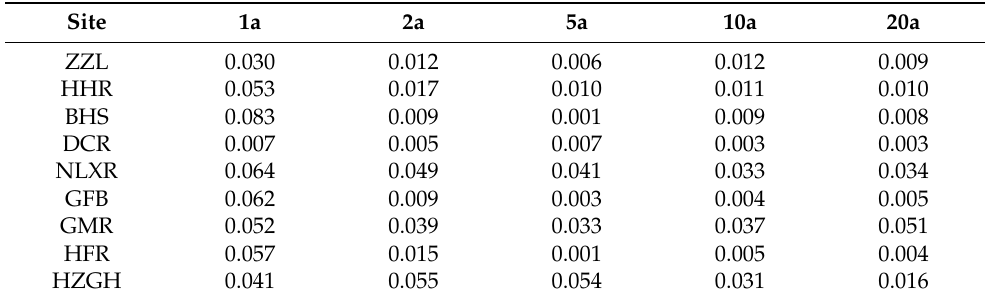
Table 13. Changes of maximum waterlogging depth under RCP4.5 compared with RF period (unit: m).